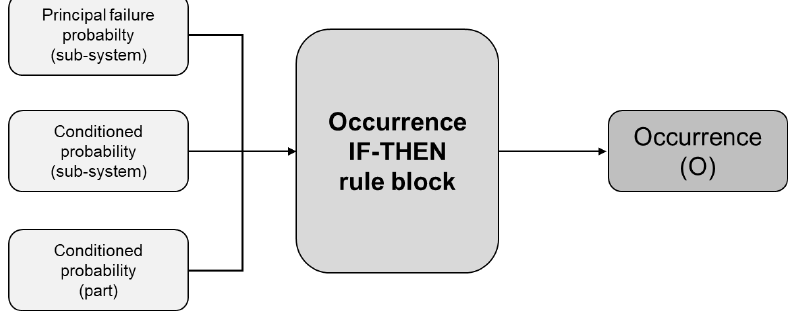
Figure 1. Logical scheme if inference rules for the FMECA index Occurrence (O).